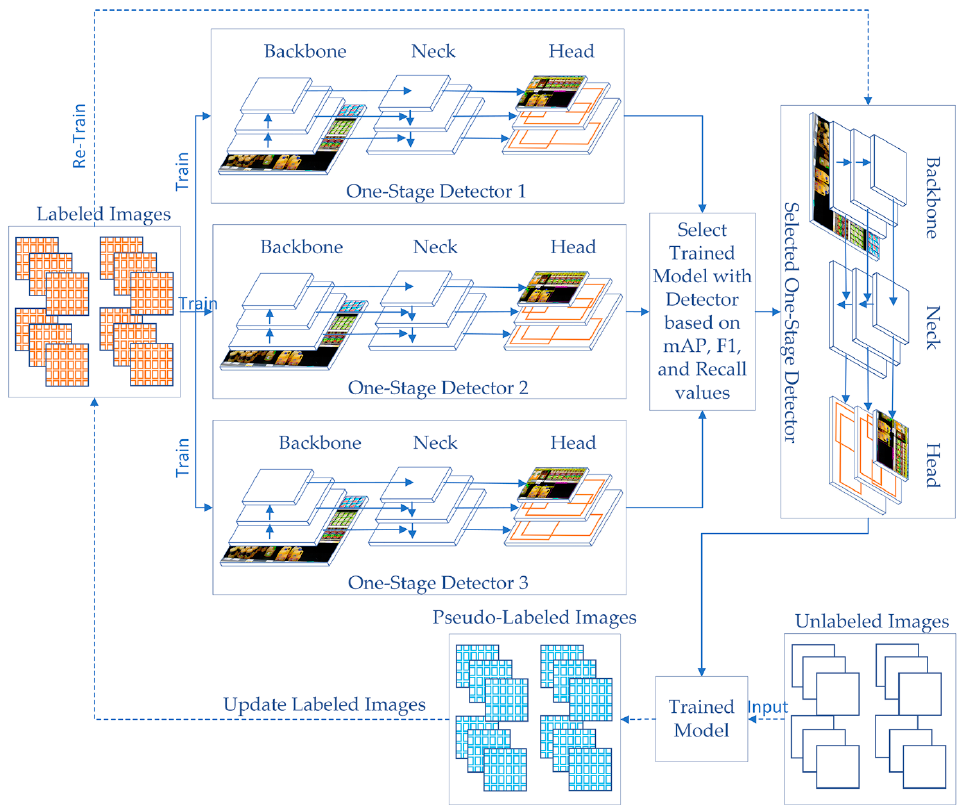
Figure 2. The general structure of the proposed SOSA approach.